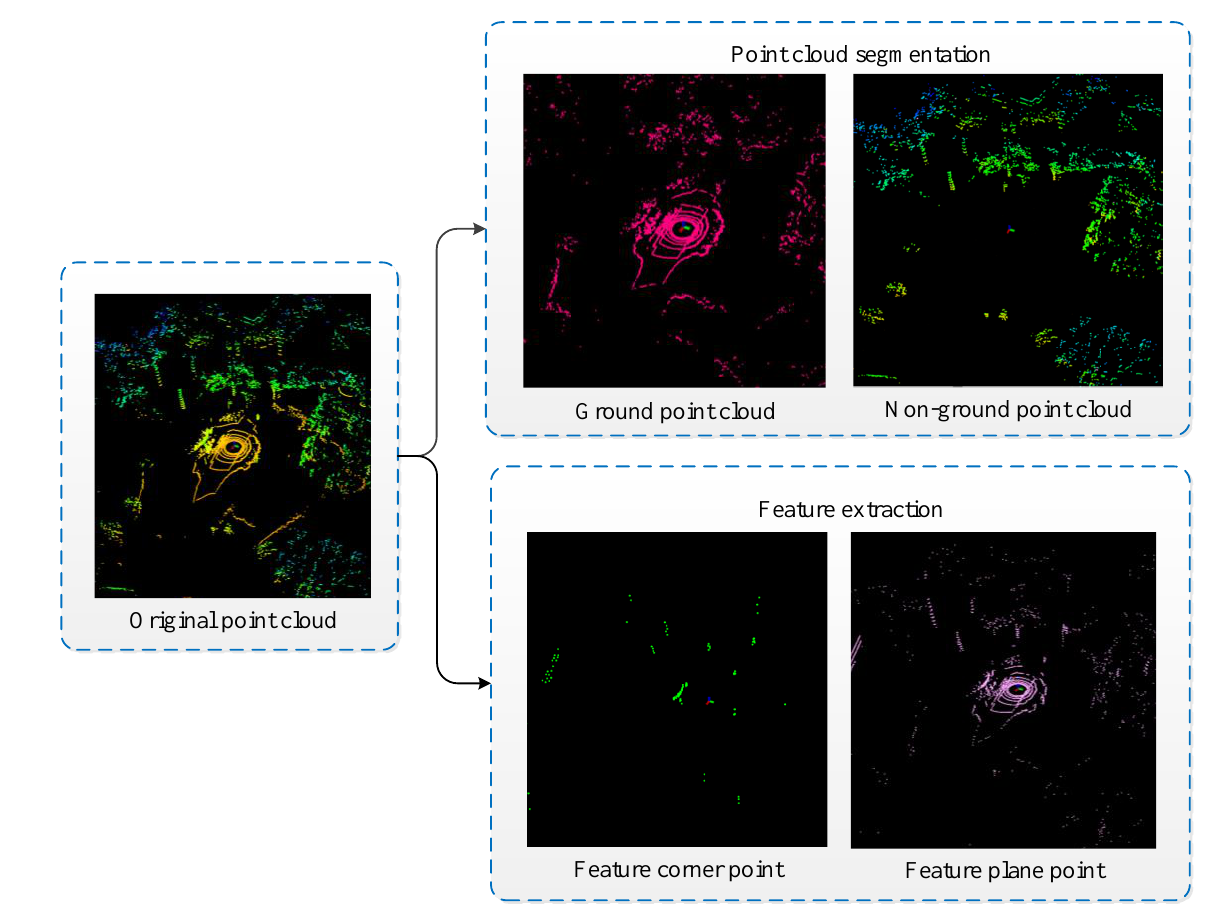
Figure 7. Point cloud preprocessing experiment.